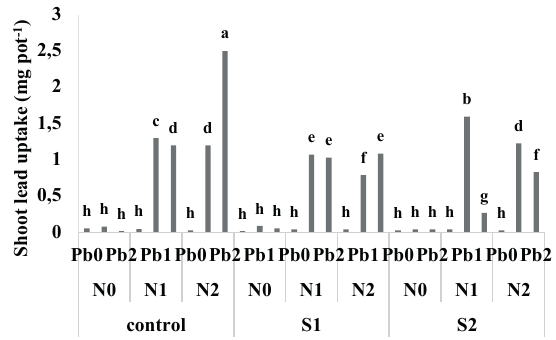
Figure 2. Shoot lead (Pb) uptake in Japanese raisin in response to salinity (S0: Control, S1: 3 and S2: 6 dSm -1 ), nitrate (N0: 0, N1: 30 and N2: 60 mgL -1 ), and Pb (Pb0: 0, Pb1: 300 and Pb2: 600 mgL -1 ). Values in each group followed by the same letter are not significant- ly different according to DMRT at